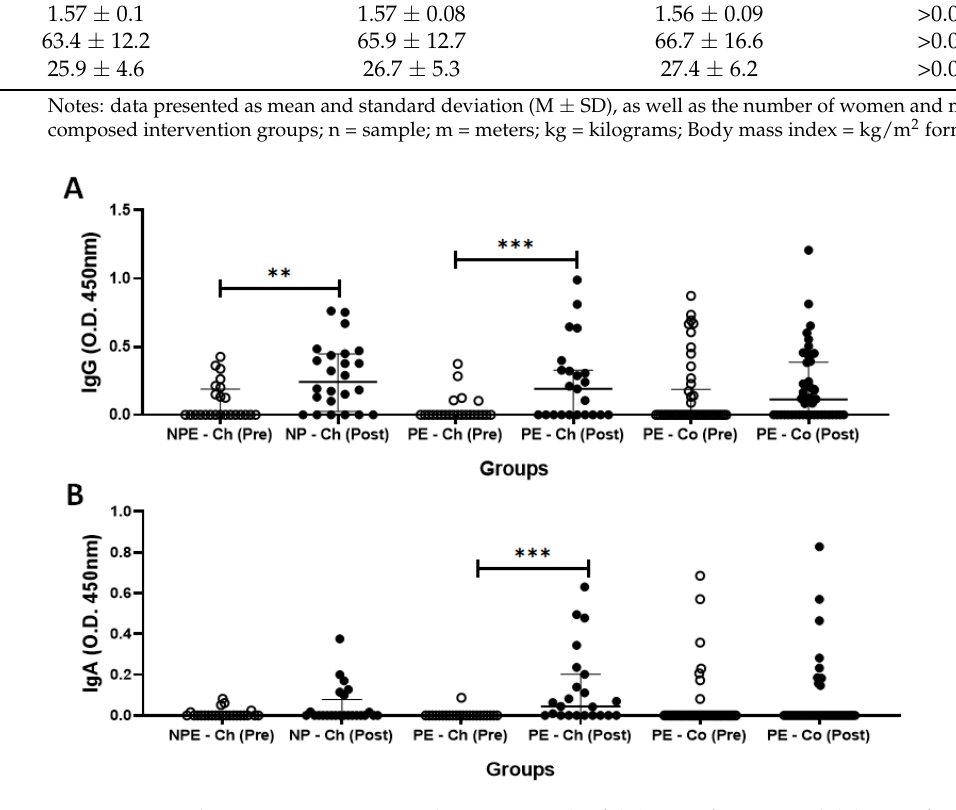
Figure 4. Total serum concentration (O.D. 450 nm) of ( A ) specific IgG and ( B ) specific IgA for SARS-CoV-2 antigens before (pre) and after 30 days (post) of administration of the second dose of ChadOx-1 and CoronaVac vaccine in the groups of older adults who regularly practiced (PE) or not (NPE) a physical exercise program before the pandemic period. Data are presented as median and interquartile range. ** p < 0.01; *** p < 0.001. As the number of men and women enrolled in the groups vaccinated with ChadOx- 1 showed significant differences, we performed an evaluation of the specific antibody response (IgG and IgA) for SARS-CoV-2 antigens separating the volunteers by gender. As presented in Supplementary Figure S1 (SF1), the intragroup analysis showed higher specific IgG levels both in the subgroup of older men who composed the NPE group (SF1-A, p = 0.02) and older women who composed the PE group (SF1-A, p = 0.01) post-vaccination than the values pre-vaccination. In relation to specific IgA levels SF1-B), both subgroups of older men and older women from the PE group showed significantly increased levels of this antibody post-vaccination as compared to the value’s pre-vaccination ( p = 0.03 and p = 0.006, respectively). In the intergroup analysis, no differences were found between the subgroups of men and women who composed NPE and PE